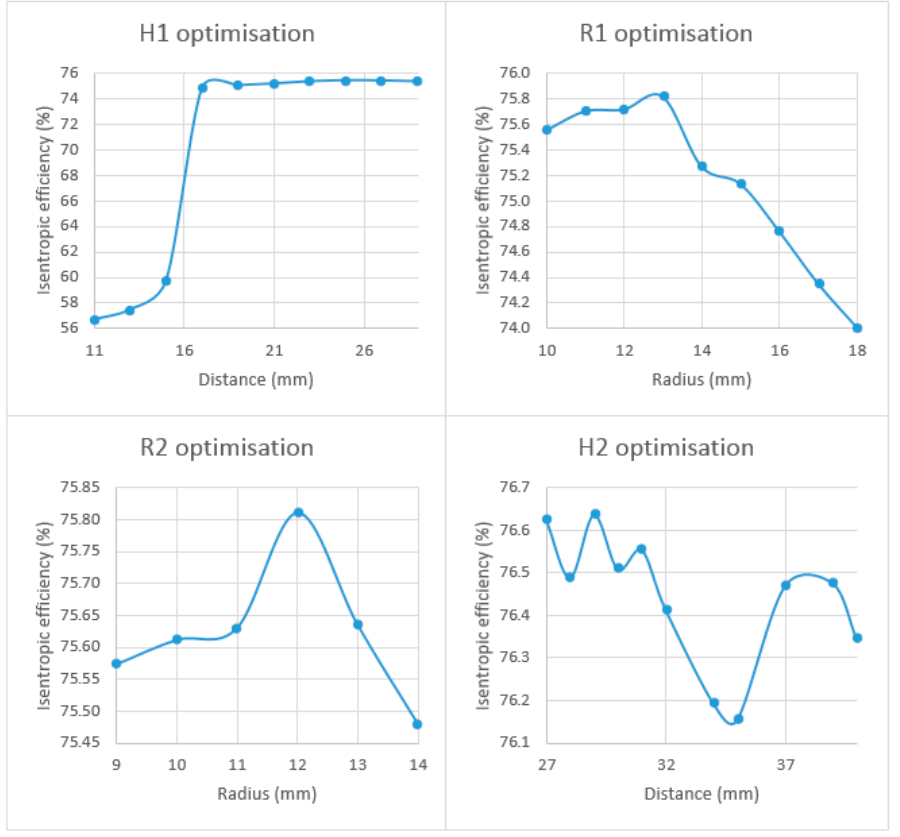
Figure 10. Results of the first stage of the parametric volute optimisation process.